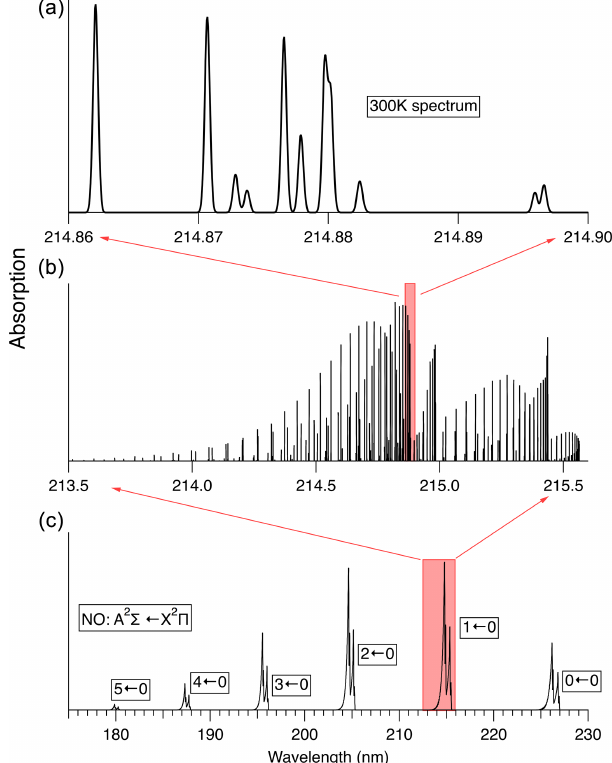
Figure 3. Spectrum of the A 2 (cid:54) ← X 2 (cid:53) transition in NO at 300K. (c) shows the absorption spectrum in low resolution. (b) shows the calculated stick spectrum for the 1 ← 0 transition. (a) shows the spectral region used here to measure NO, convolved with a 0.1cm − 1 width Gaussian lineshape, which is the Doppler linewidth of NO at